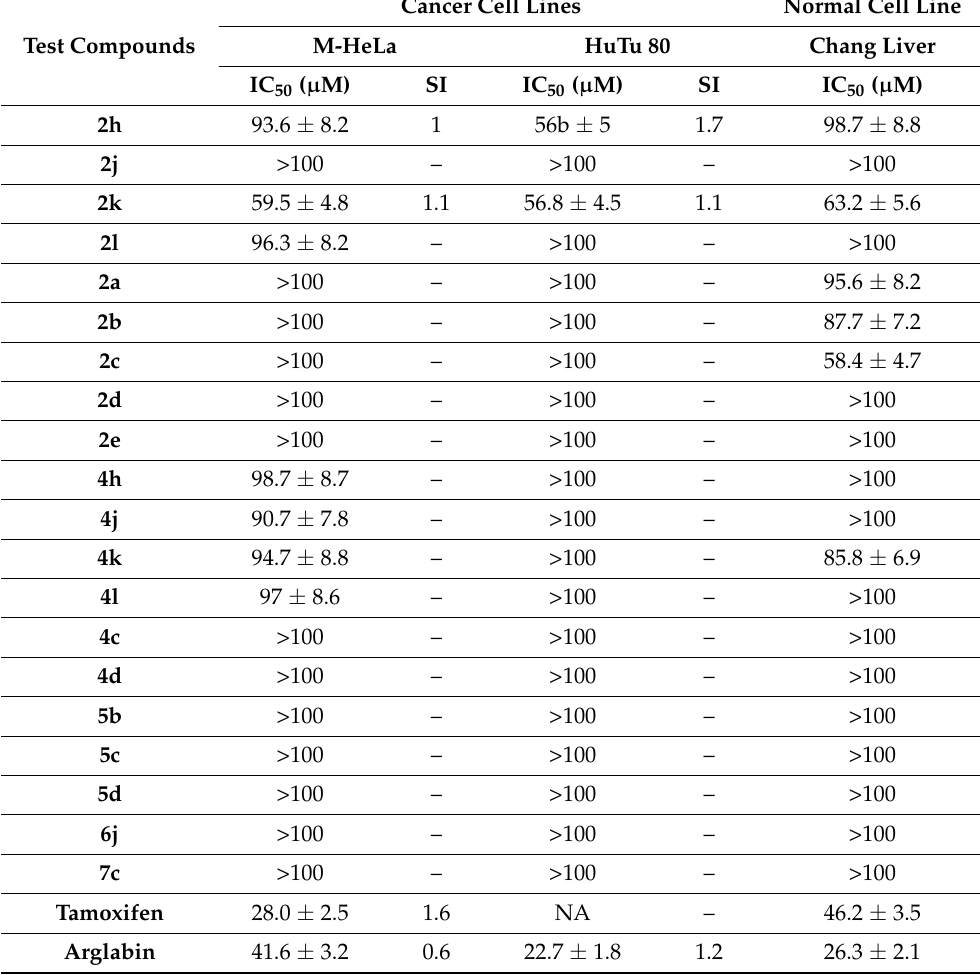
Table 1. Cytotoxic effects of imidazodin-2-ones 2 on the cancer and normal human cell lines 1 .